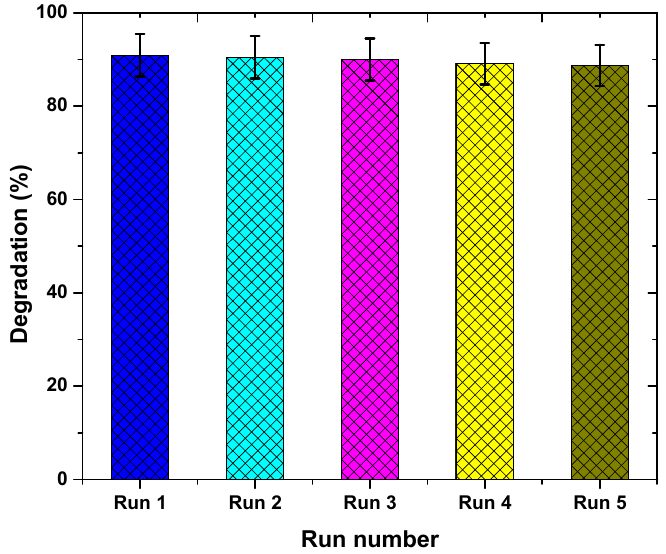
Figure 9. Reusability test of Ag/TiO 2 over 5 degradation cycles with 5 ppm dye concentration.